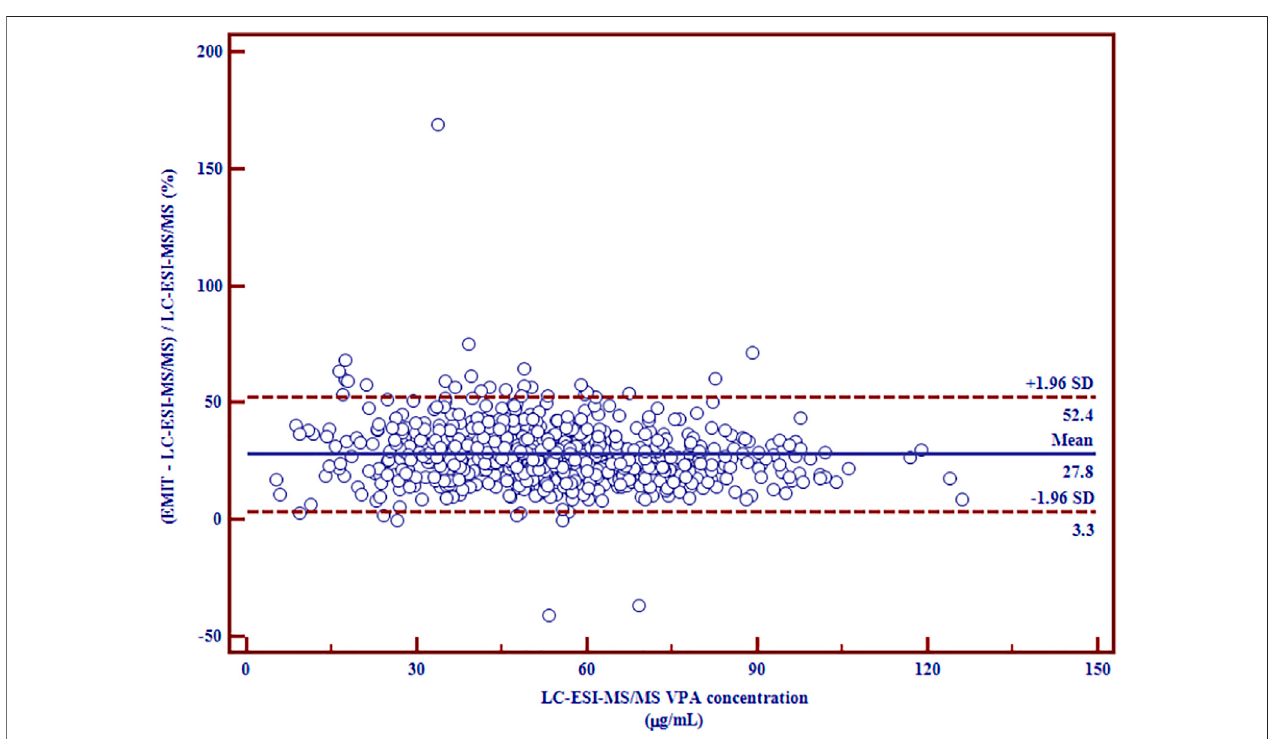
FIGURE 3 | Relative differences between mean plasma VPA concentrations (µg/ml) measured by LC-ESI-MS/MS and EMIT assay expressed in percentage ( n (cid:2) 774).